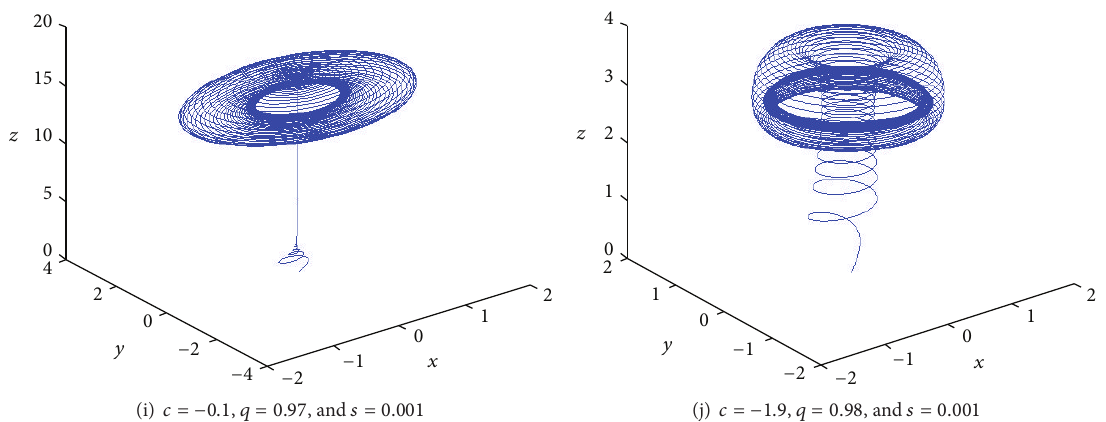
Figure 3: Trajectory of system (15) in phase space when 𝑎 = 0.4 and 𝑏 = 3